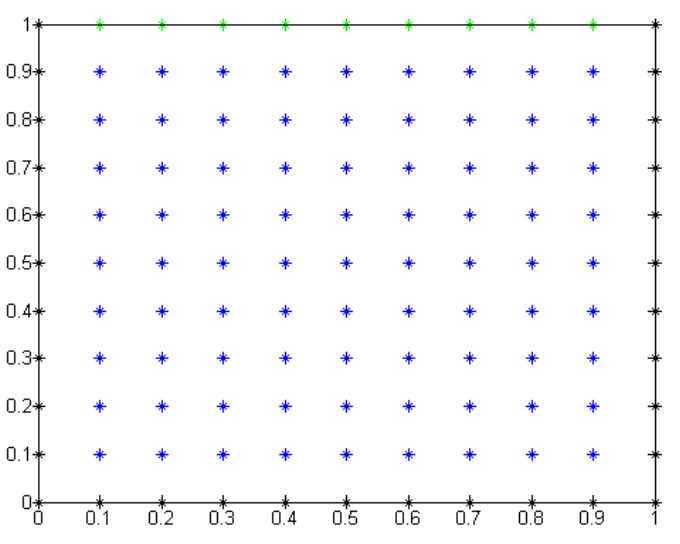
Figure 3. First cloud of points for the 2D examples (Cloud 1).